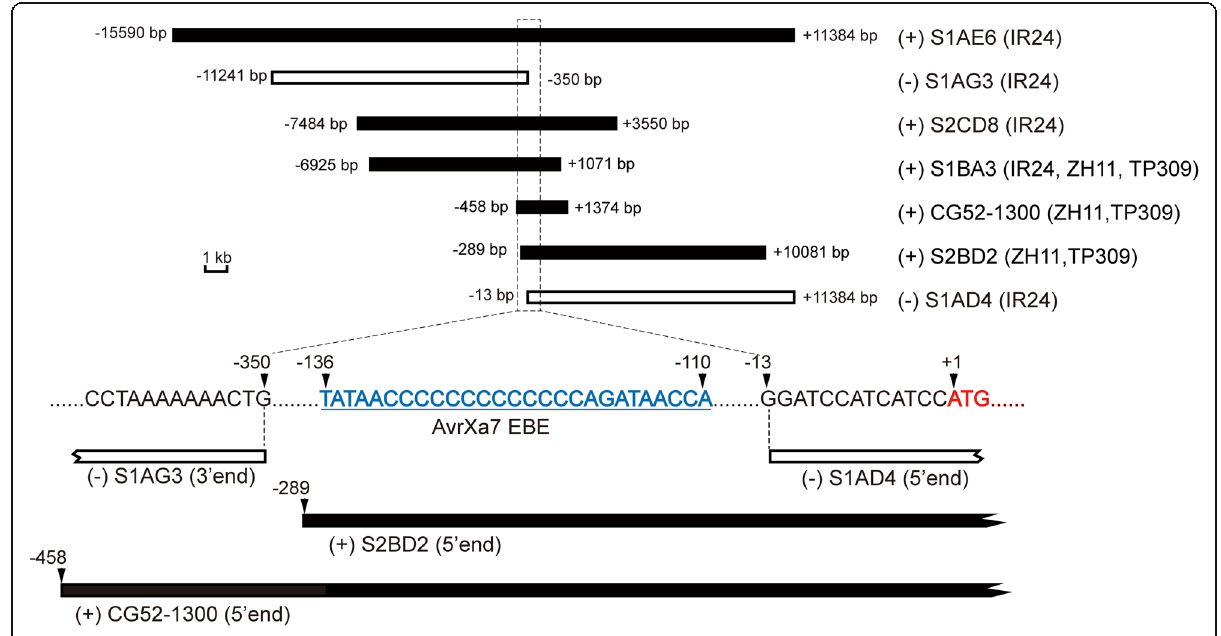
Fig. 2 Functional complementation assay for the Xa7 candidate gene. The TAC sub-clones used for rice transformation are indicated with empty and filled rectangles. The empty rectangles represent the subclones generating susceptible transgenic lines, while filled rectangles represent the subclones generating transgenic resistant lines. The positional information of the inserted fragments is shown flanking the rectangles. Negative numbers indicate a distance upstream of the ATG code initiation site for the candidate gene, while positive numbers indicate a downstream distance from it. The subclones that produced bacterial blight – resistant transgenic rice are marked with (+) before the clone number, otherwise they are marked with ( − ). The recipient varieties used for transformation are provided in brackets after the clone